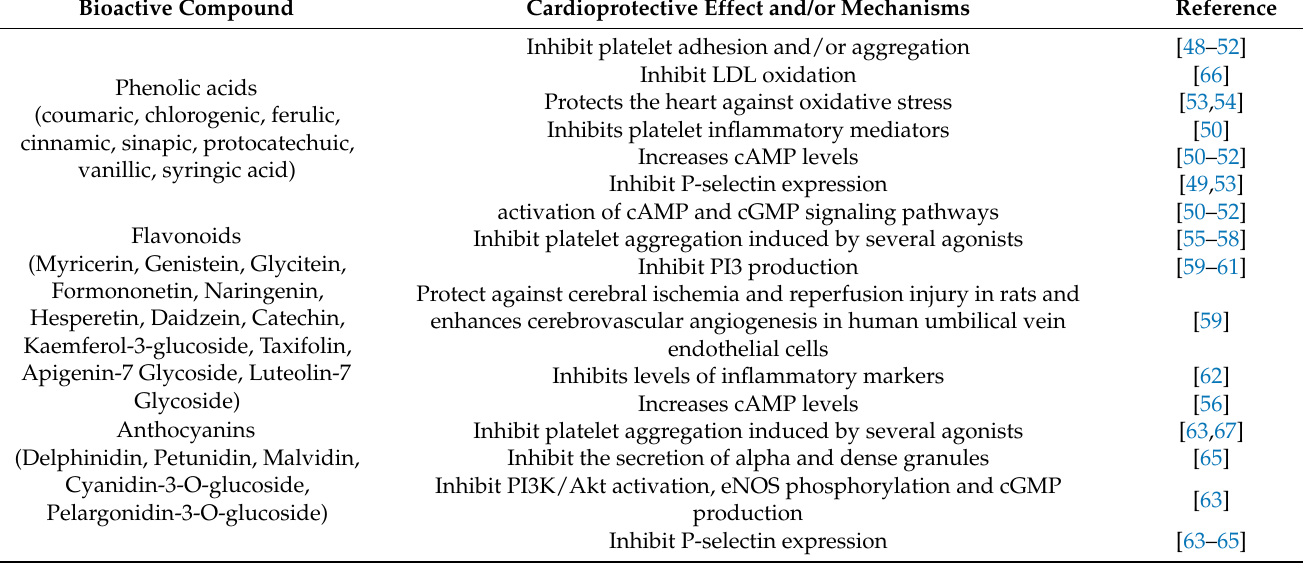
Table 3. Compounds identified on P. vulgaris L. with cardioprotective